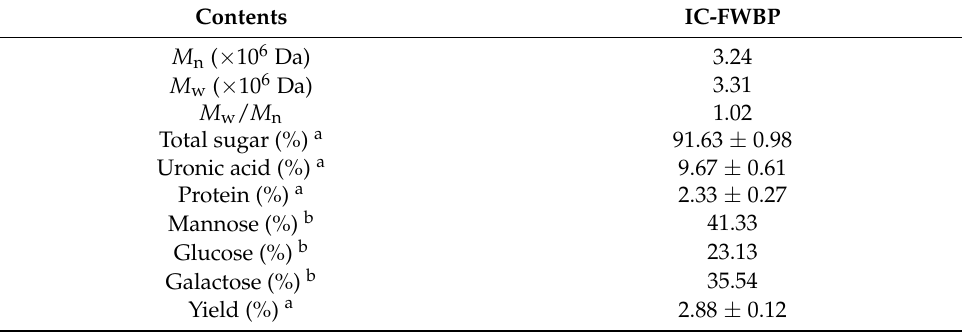
Table 1. Compositional, molecular, and structural features of the IC-FWBP.